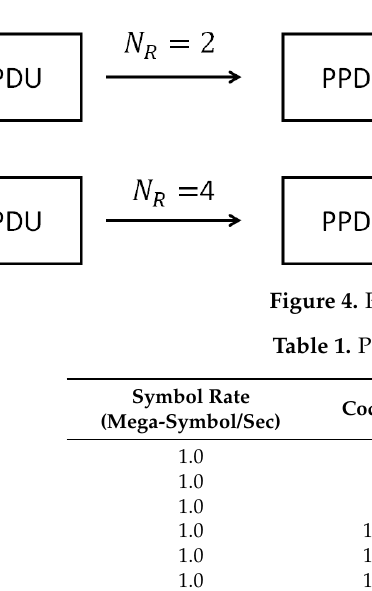
Figure 4. PPDU repetition.